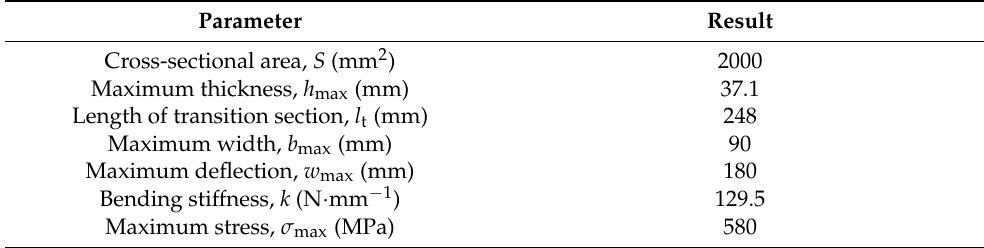
Table 2. Design results of the composite leaf